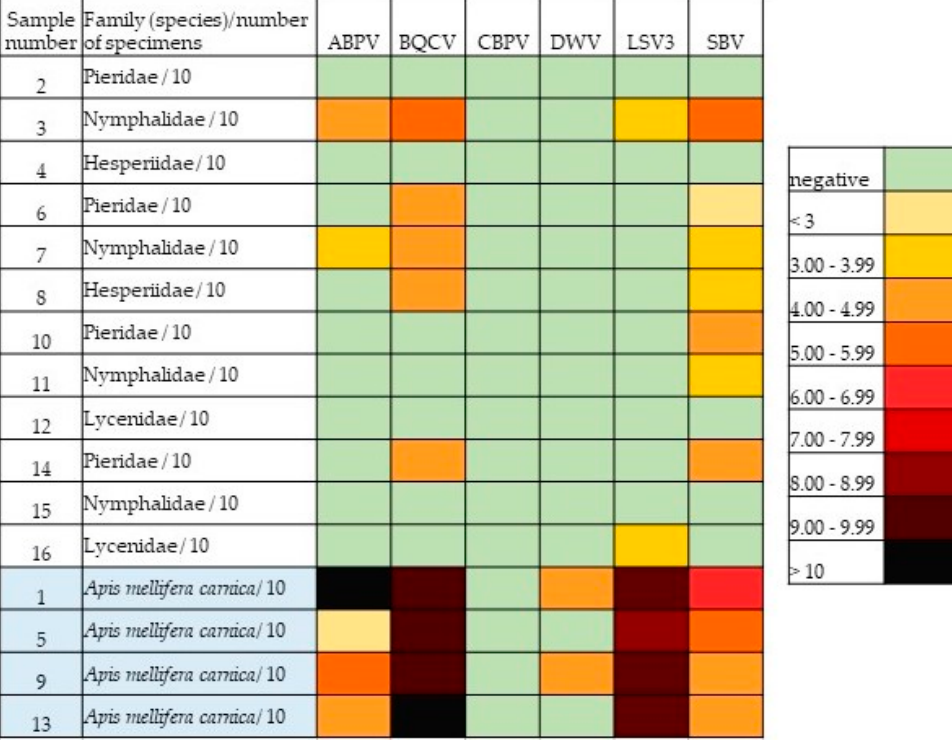
Figure 2. Percentage of positive butterfly samples compared by sampling location. Using heat map analysis, we found a clear difference in viral load between butterfly and bee samples. The bee samples contained significantly higher virus levels compared to the butterfly samples (Figure 3).